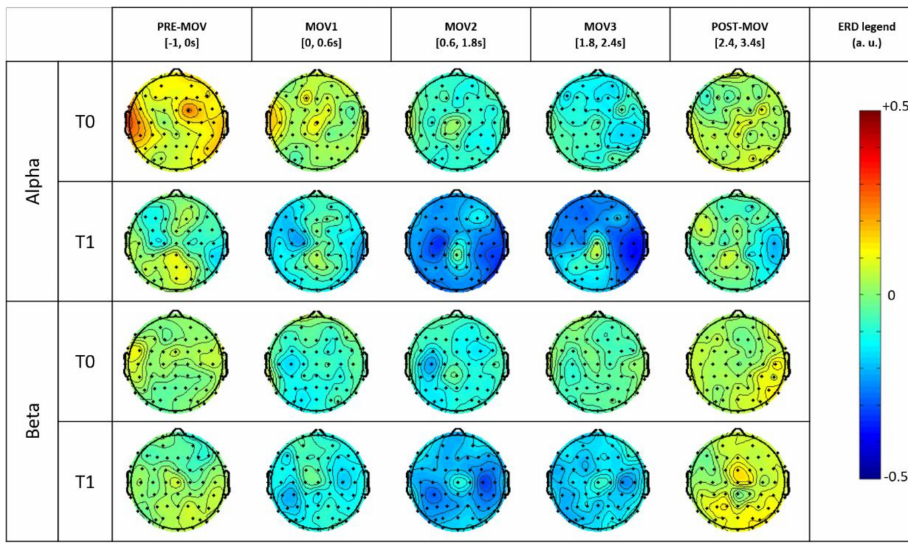
Figure 6. Topographic visualization of the average ERD (arbitrary unit) in five time windows, i.e., before movement initiation (PRE-MOV [ − 1, 0 s]), during movement (MOV1 [0, 0.6 s], MOV2 [0.6, 1.8 s], MOV3 [1.8, 2.4 s]) and after the movement termination (POST-MOV [2.4, 3.4 s]). The maps